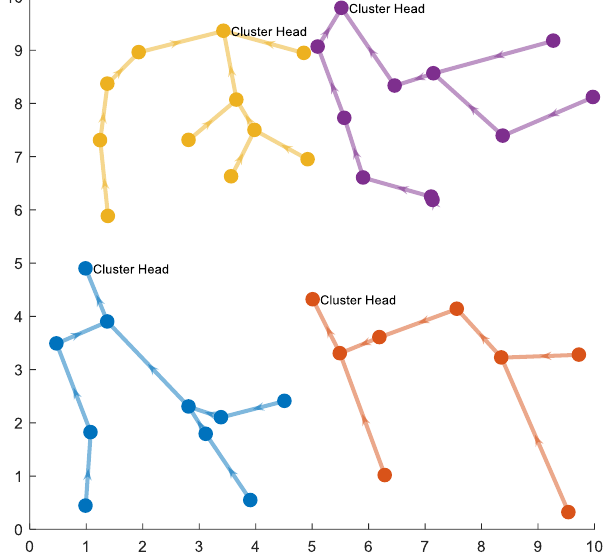
Figure 15. Illustration of clustering for a general topology model.